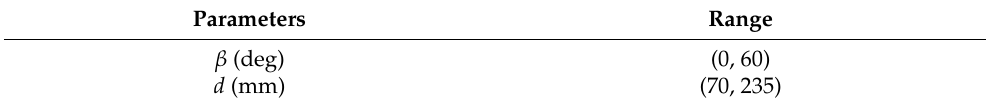
Table 3. Range of the optimized variables.